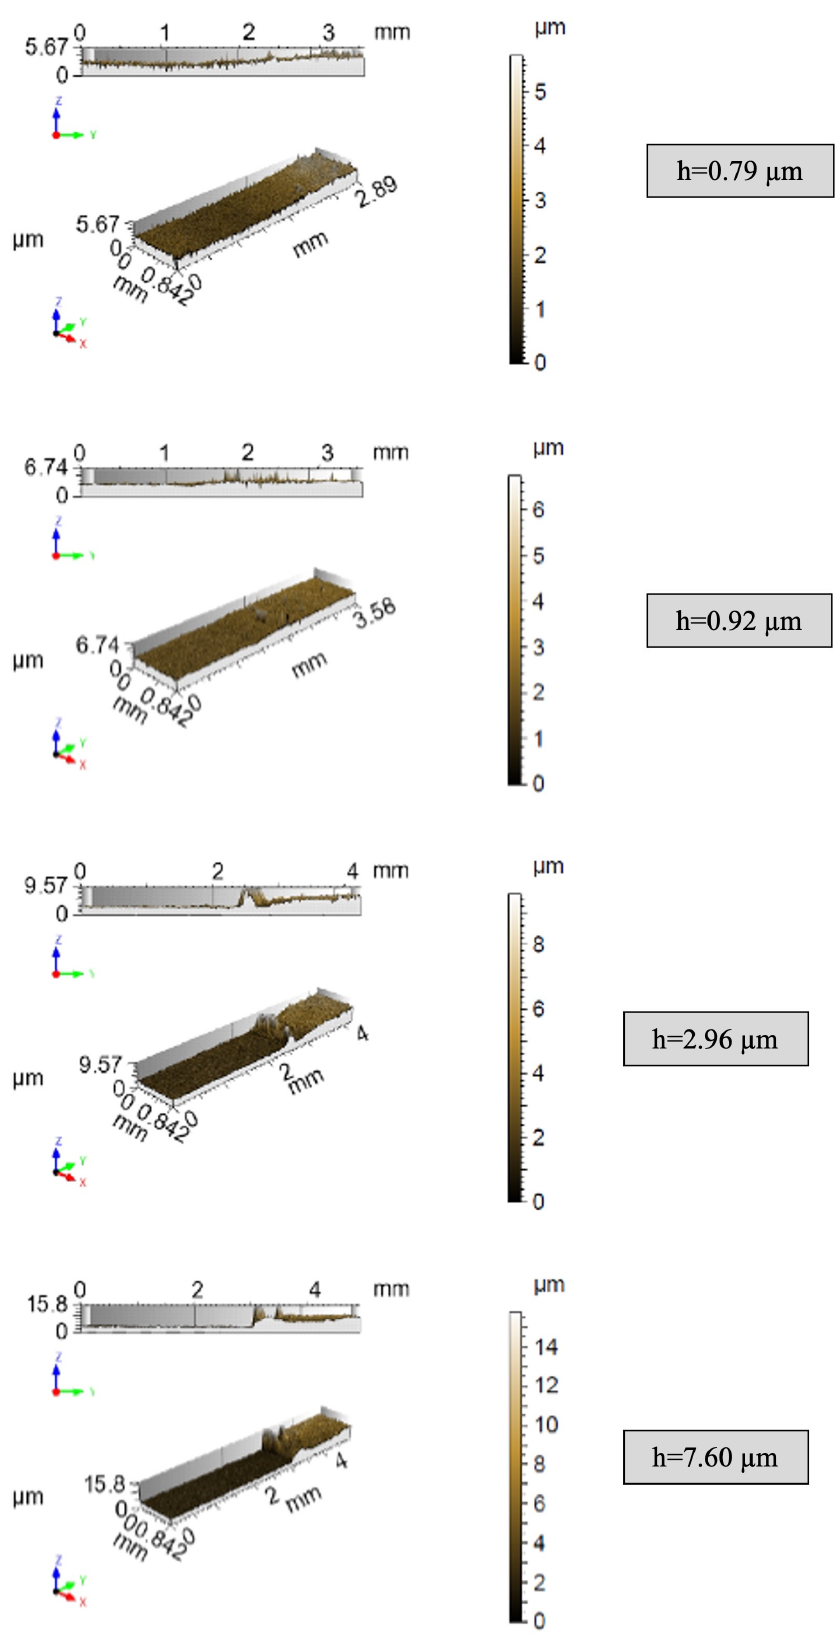
Figure 6. Profiles and 3D images between substrates and coatings average thickness (h) analysis according to deposition times (1 min, 2 min, 5 min, and 10